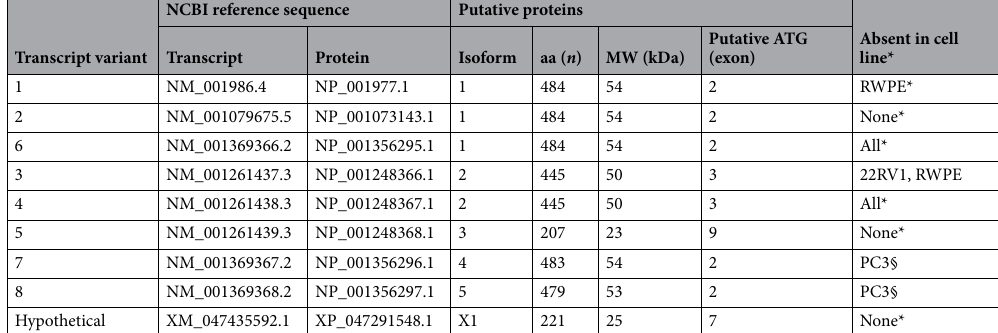
Table 1. List of ETV4 transcripts reported in NCBI Reference Sequences database and their presence in human cell lines. The NCBI Reference Sequences (RefSeq) sequence number and the characteristics of the putative proteins (including the exon in which the start codon is located) are reported for each transcript and protein isoform. The isoform X1 in which the exon 8 is skipped is reported in the NCBI RefSeq database as predicted protein. aa: amino acids; n : number; MW: molecular weight; kDa: kilodalton. *The investigated cells lines are: PC3, Du145, RWPE, 22RV1 (prostate); MDA-MB-231 (breast), K562 (myeloid leukemia); § only PC3 and Du145 have been